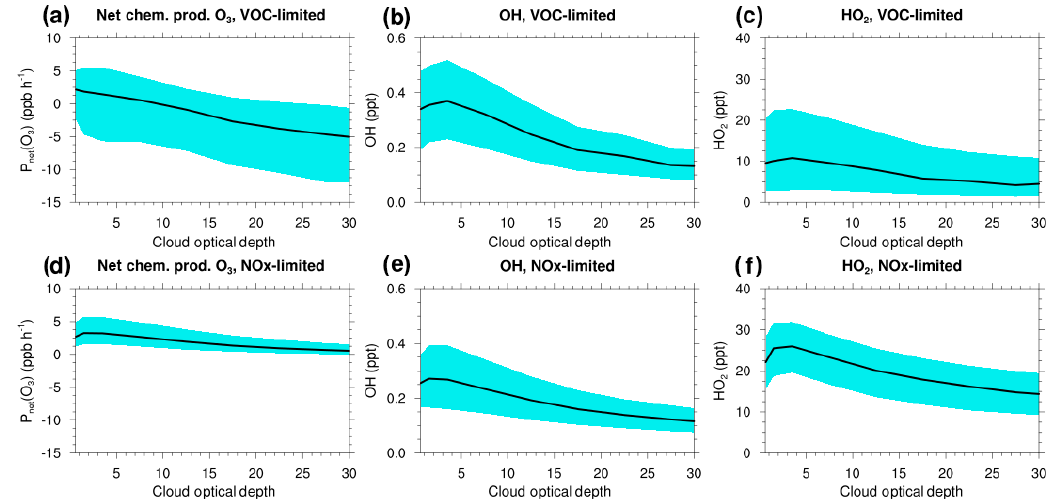
Figure 8. (a) Net chemical production of O 3 , (b) OH concentration, and (c) HO 2 concentration with variations of cloud optical depth for the VOC-limited regime. The black line indicates the median, and cyan shading indicates the 25th and 75th percentiles. Similar variables are shown for the NO x -limited regimes (d–f)